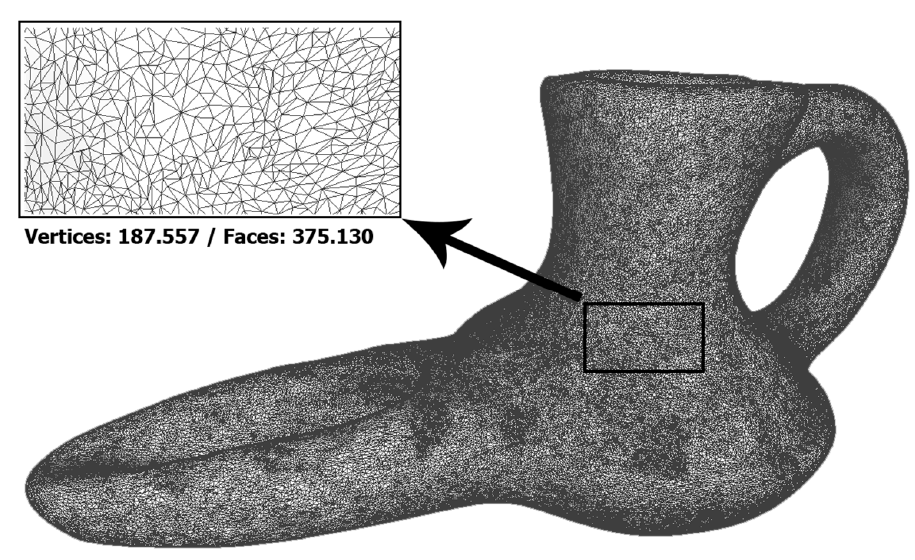
Figure 12. Meshes obtained by Artec Spider. (Source: self-made).